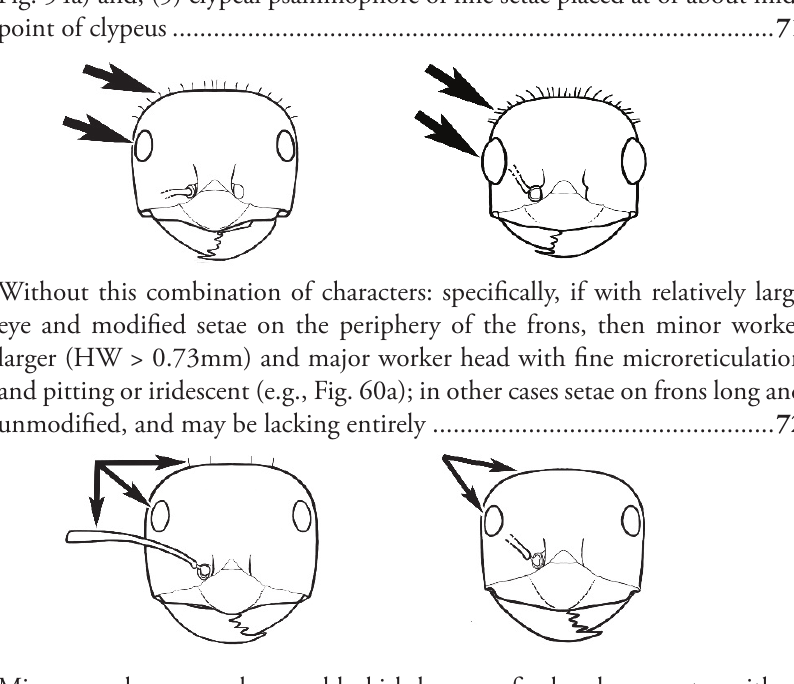
Fig. 54a) and, (5) clypeal psammophore of fine setae placed at or about mid-